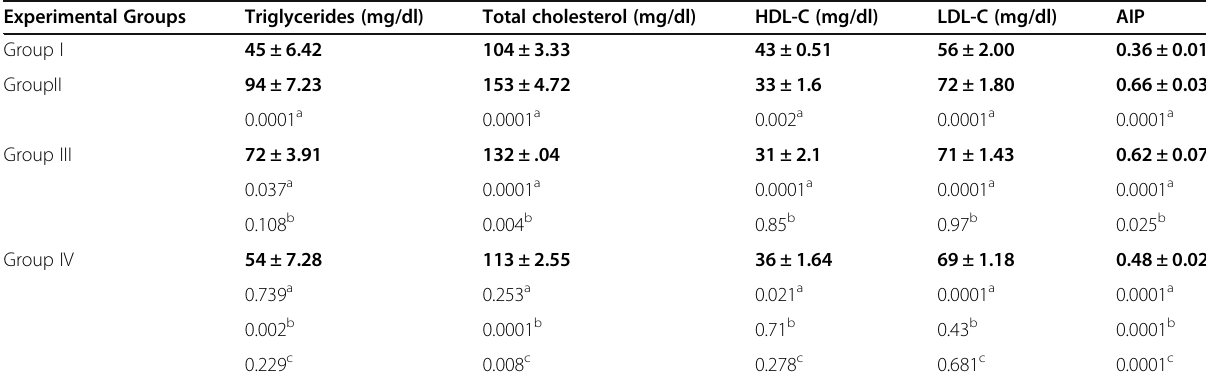
Table 3 Effect of AuNPs on lipid profile of experimental groups Experimental Groups